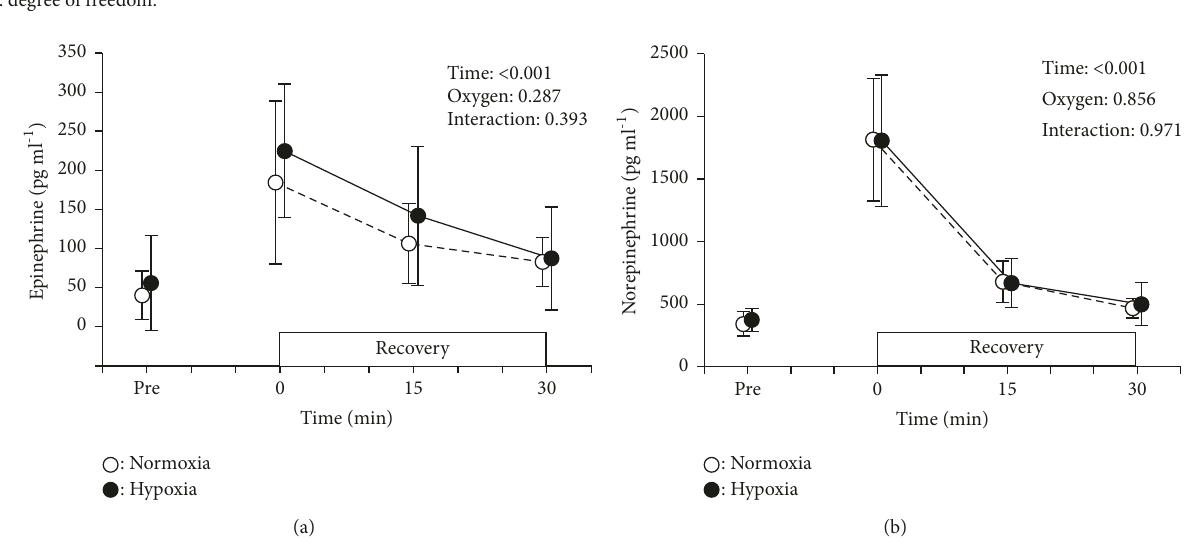
Figure 4: Changes in plasma epinephrine (panel (a)) and norepinephrine (panel (b)) at baseline (pre), immediately after resistance exercise (time = 0) and during the first 30 min of recovery. Circles indicate the same as in Figure 2.